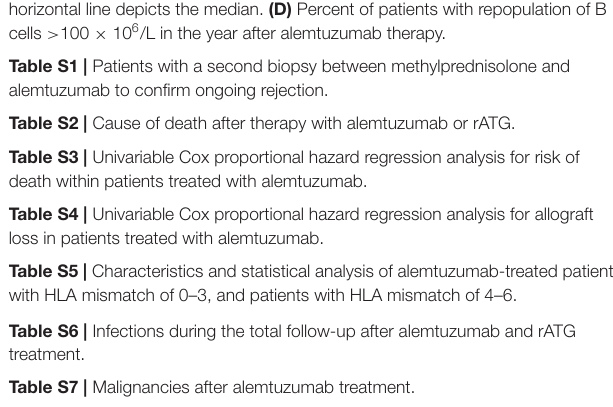
Table S2 | Cause of death after therapy with alemtuzumab or rATG.